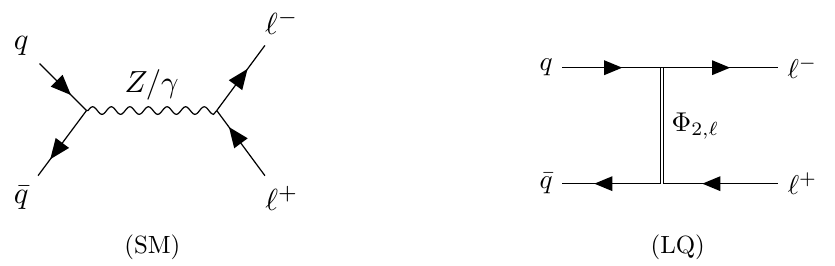
Figure 2. The leading-order SM and LQ diagrams (drawn with TikZ-Feynman [225]) that contribute to di-lepton production pp → ‘ + ‘ − at the LHC. While the SM contribution occurs via the s -channel exchange of a (virtual) photon or Z -boson, the LQ diagram on the right features a t -channel exchange and receives an enhancement at high di-lepton invariant